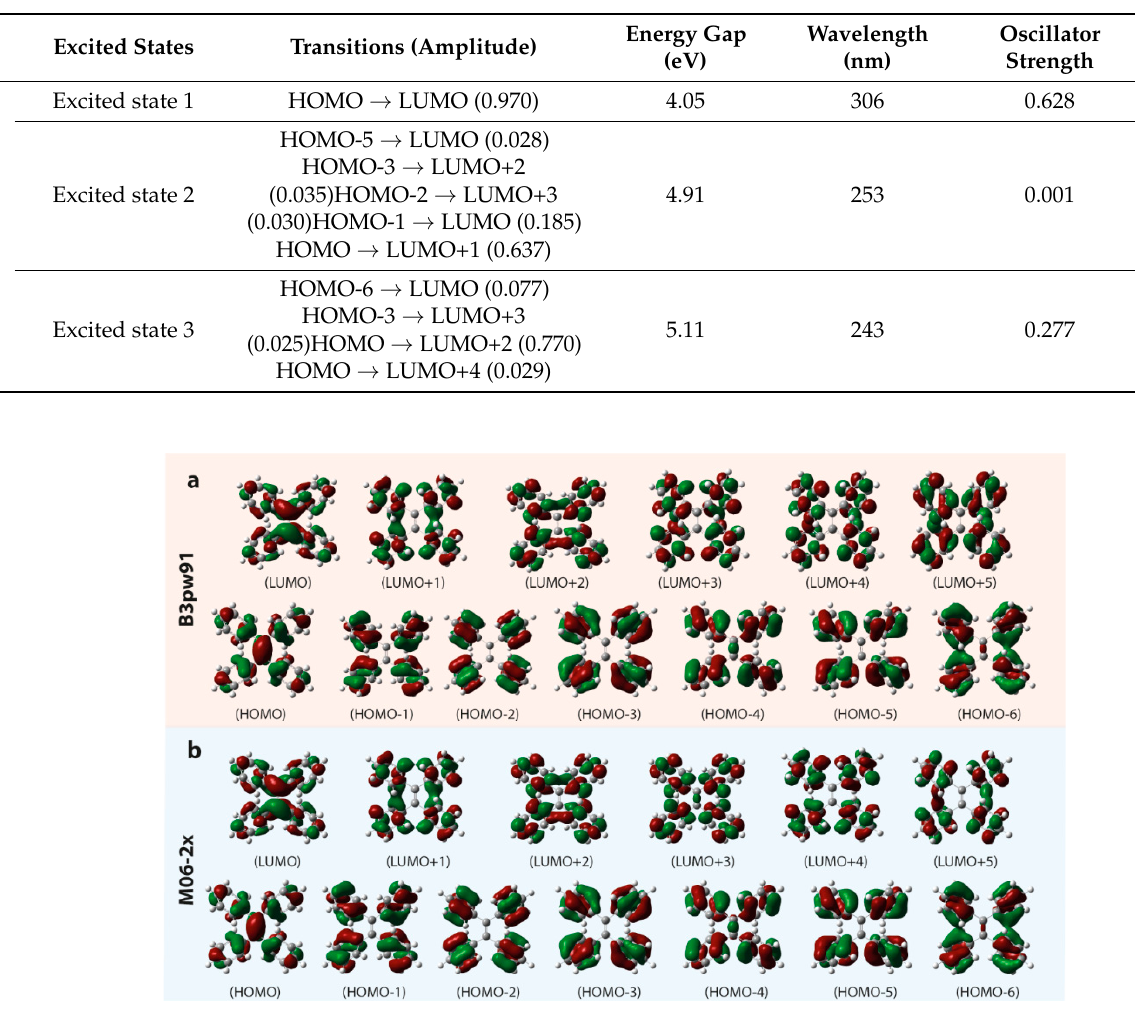
Figure 9. Electron density contours of the orbitals of TPE in THF solvent (contour level = 0.03) operated at the tda/( a ) b3pw91 or ( b ) m06-2x/6-31g(d,p)/scrf=(iefpcm,solvent=thf) level of theory.